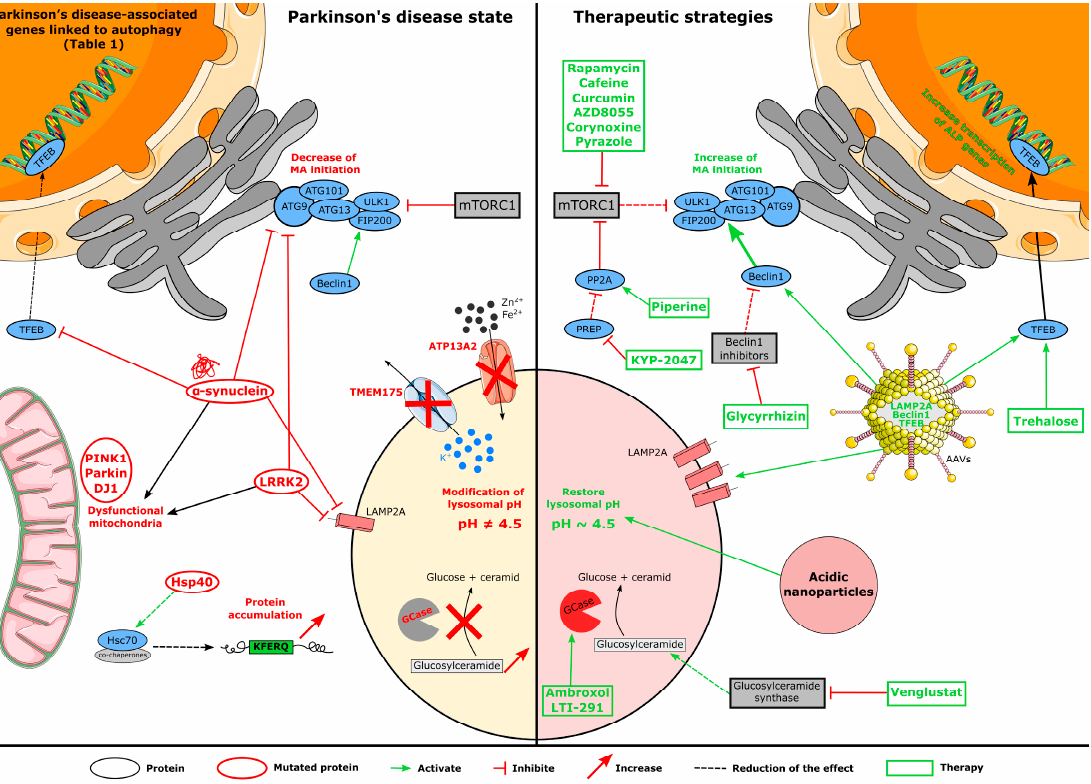
Figure 2. Schematic representation of the impact of mutated proteins on the autophagy mechanism ( left panel ) and the targets of different treatments on autophagy ( right panel